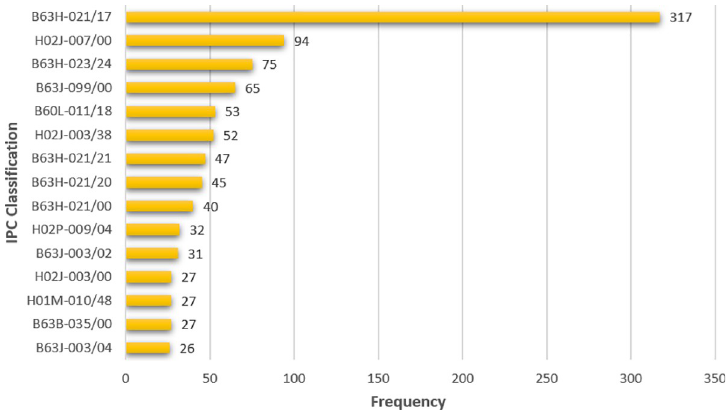
Fig 1. IPC number statistics of deweighting data (part).